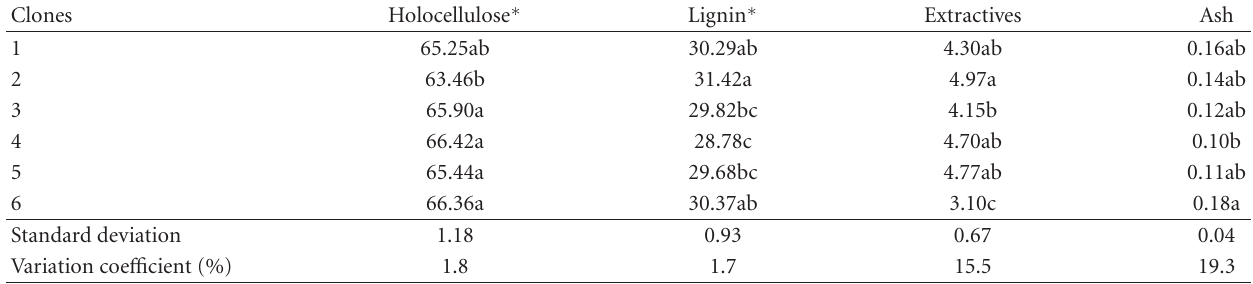
Table 2: Average values of holocellulose, lignin, extractives, and ash of Eucalyptus spp. wood, in percentage.